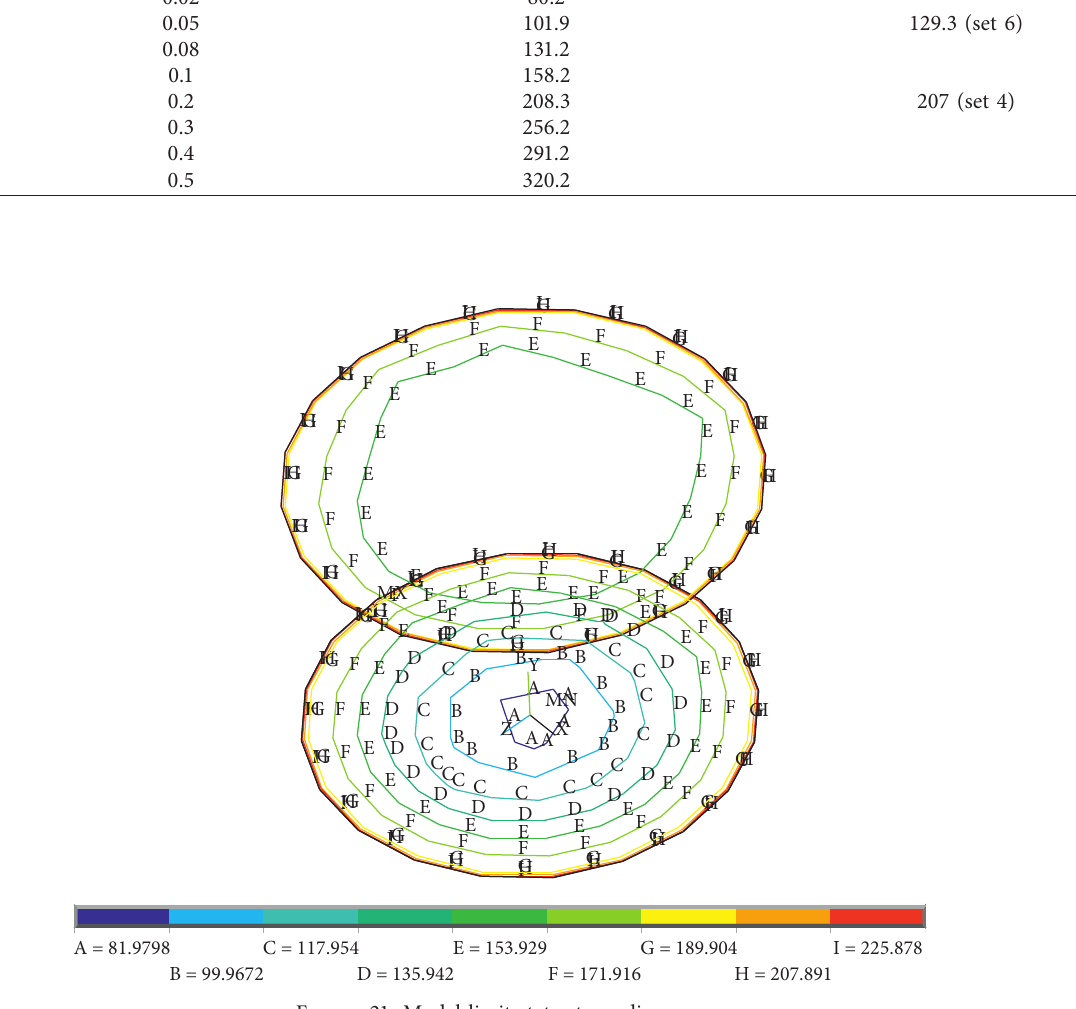
Figure 21: Model limit state stress